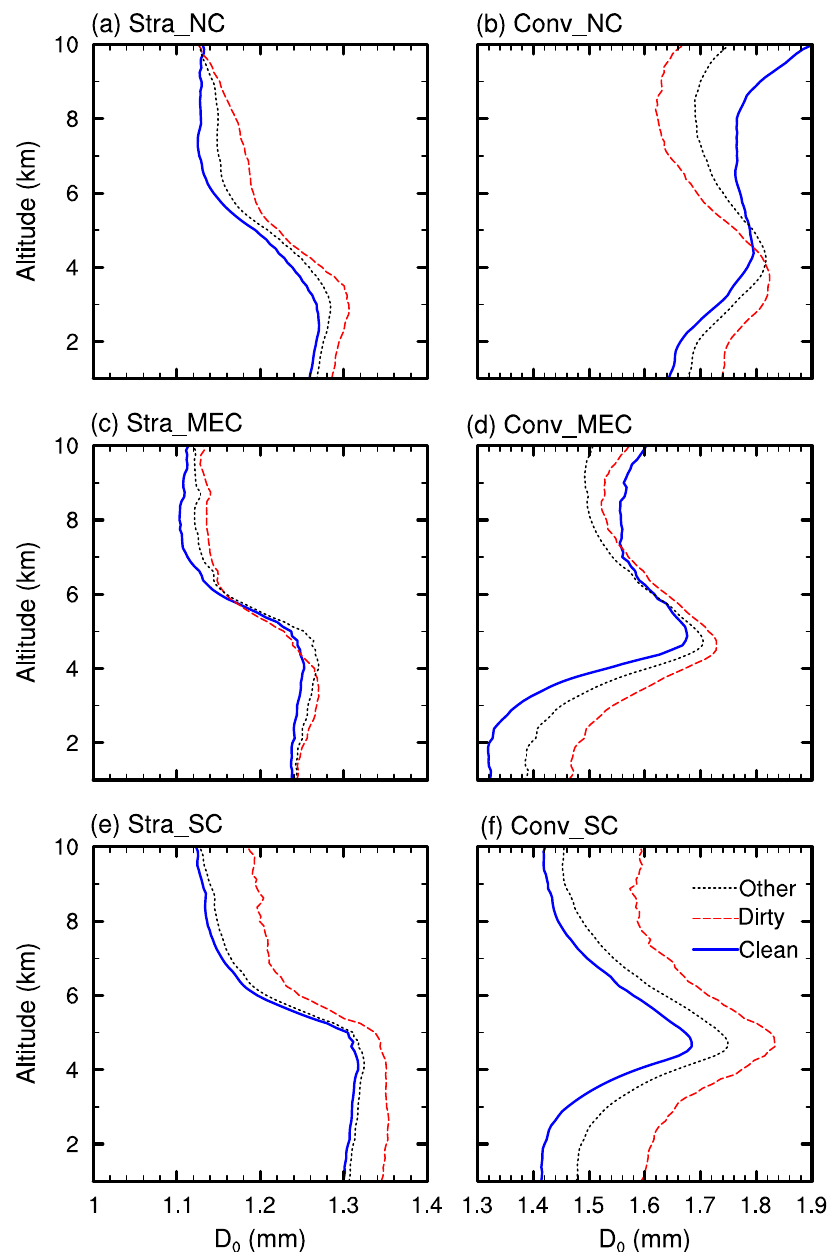
Fig. 4 The effective radius (D 0 ) pro fi les under “ Clean, ” “ Dirty, ” and “ Other ” conditions. a Stratiform precipitation in NC. b Convective precipitation in NC. c Stratiform precipitation in MEC. d Convective precipitation in MEC. e Stratiform precipitation in SC. f Convective precipitation in